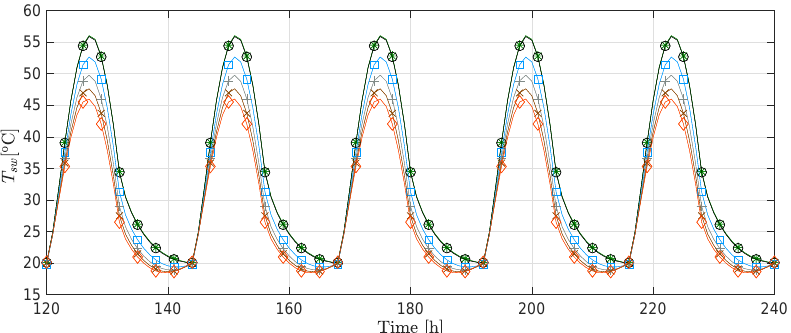
Figure 2. Surface temperature on the brick wall (bare facade), T sw , over time—sensitivity to wind speed, v : ( ∗ ) 0.0 m/s; ( ◦ ) 0.5 m/s; ( (cid:3) ) 1.5 m/s; (+) 2.5 m/s; ( × ) 3.5 m/s; ( (cid:5) ) 4.5 m/s.